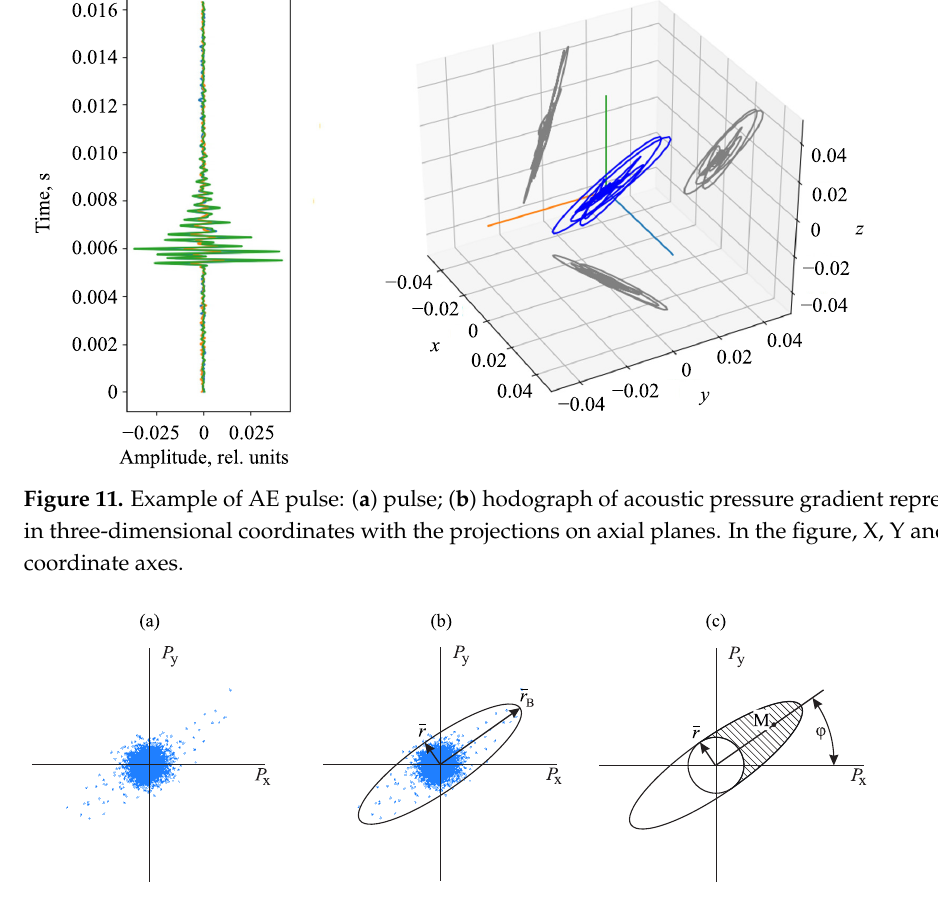
Figure 12. Determination of the direction to a signal source: ( a ) projections of pulse samples on the XY plane, ( b ) mapping of the describing ellipse and determination of noise level and ( c ) elimination of count direction ambiguity, estimation of mass center M and determination of azimuth on the signal